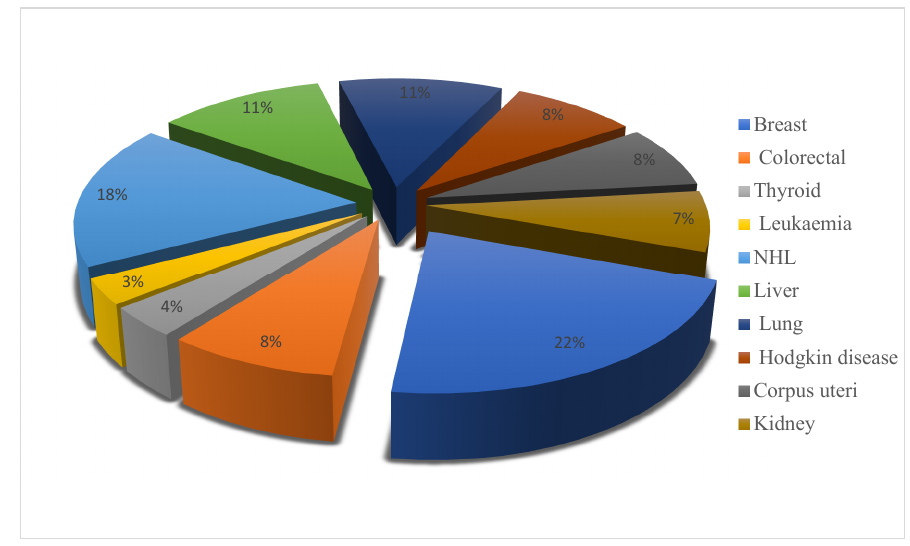
Figure 3. The 10 most common cancers in Saudi Arabia in 2012.